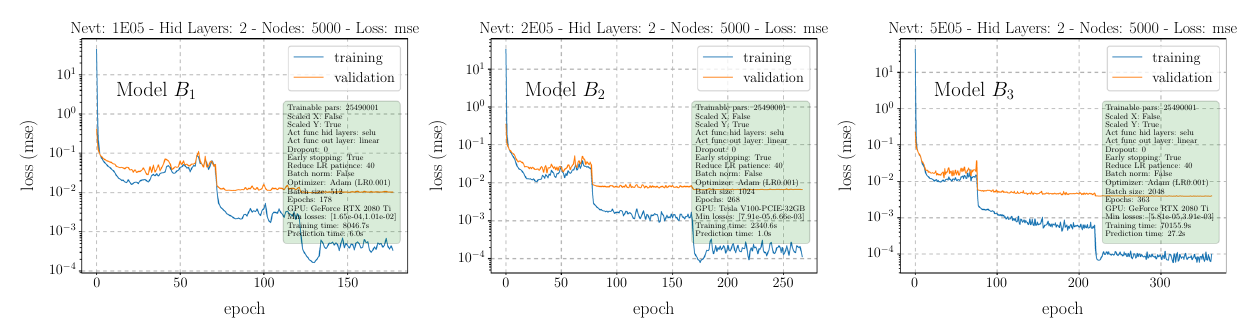
Fig. 8 Training and validation loss (MSE) vs number of training epochs for models B 1 − B 3 . The jumps correspond to points of reduction of the Adam optimiser learning rate